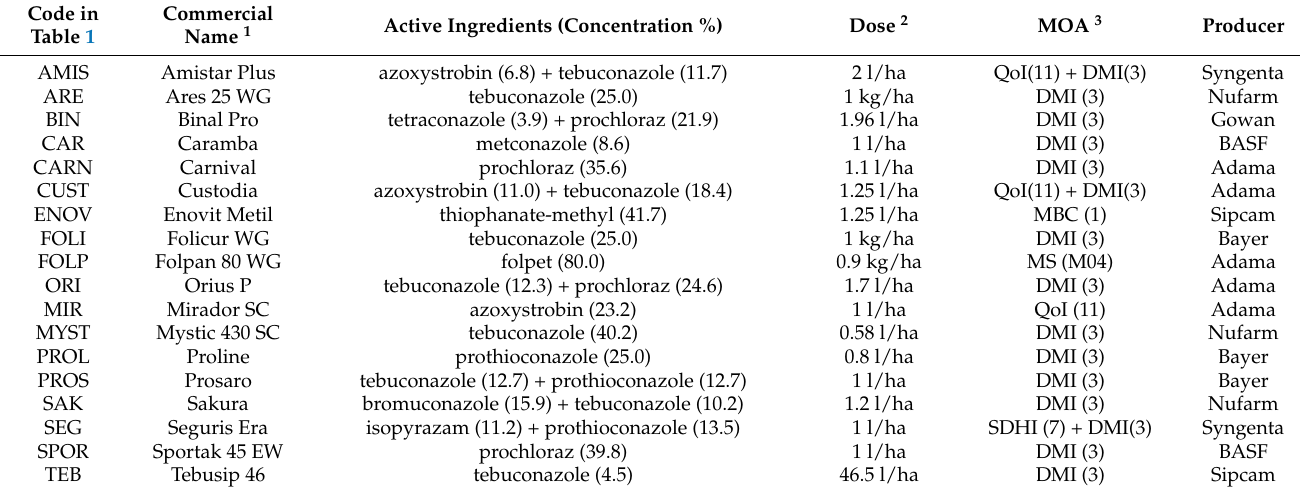
Table 2. Characteristics of the commercial products used in the experiments described in Table